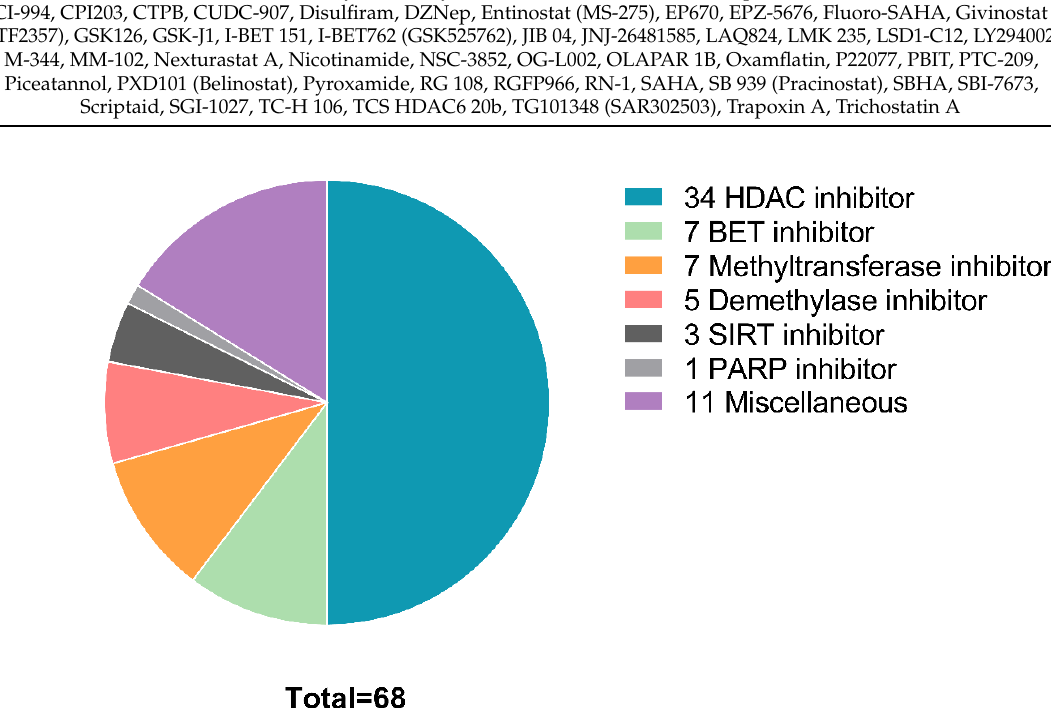
Figure 1. Distribution of compound types that showed efficacy in at least one sample. BET, bromodomain and extra-terminal motif; HDAC, histone deacetylase; SIRT, surtuin; PARP, poly (ADP-ribose) polymerase. While HDAC inhibitors represent the compound class with the most positive hits overall (n = 34), BET inhibitors are the second largest group of positive hits (n = 7). Of interest, although the use of methyltransferase inhibitors, such as Aza, is standard of care for AML [17], methyltransferase inhibitors did not have an effect in cell lines from 6 of the 9 patient-derived samples. Two methyltransferase inhibitors displayed activity in two samples, while five methyltransferase inhibitors displayed activity in only one sample (patient 9). This is likely as most patients received, and failed, standard-of-care regimens prior to the screen. Similarly, only a single demethylase inhibitor (JIB 04) displayed activity in more than one sample on the screen. Four additional demethylase inhibitors showed activity in a single sample (patient 9). One PARP inhibitor (OLAPAR 1B) displayed activity in 2 samples, while 3 SIRT inhibitors displayed activity in a single sample (patient 9). IDH inhibitors (n = 3), p300/CBP inhibitors (n = 3), and histone acetylase inhibitors (n = 6), displayed no activity in any of the evaluated